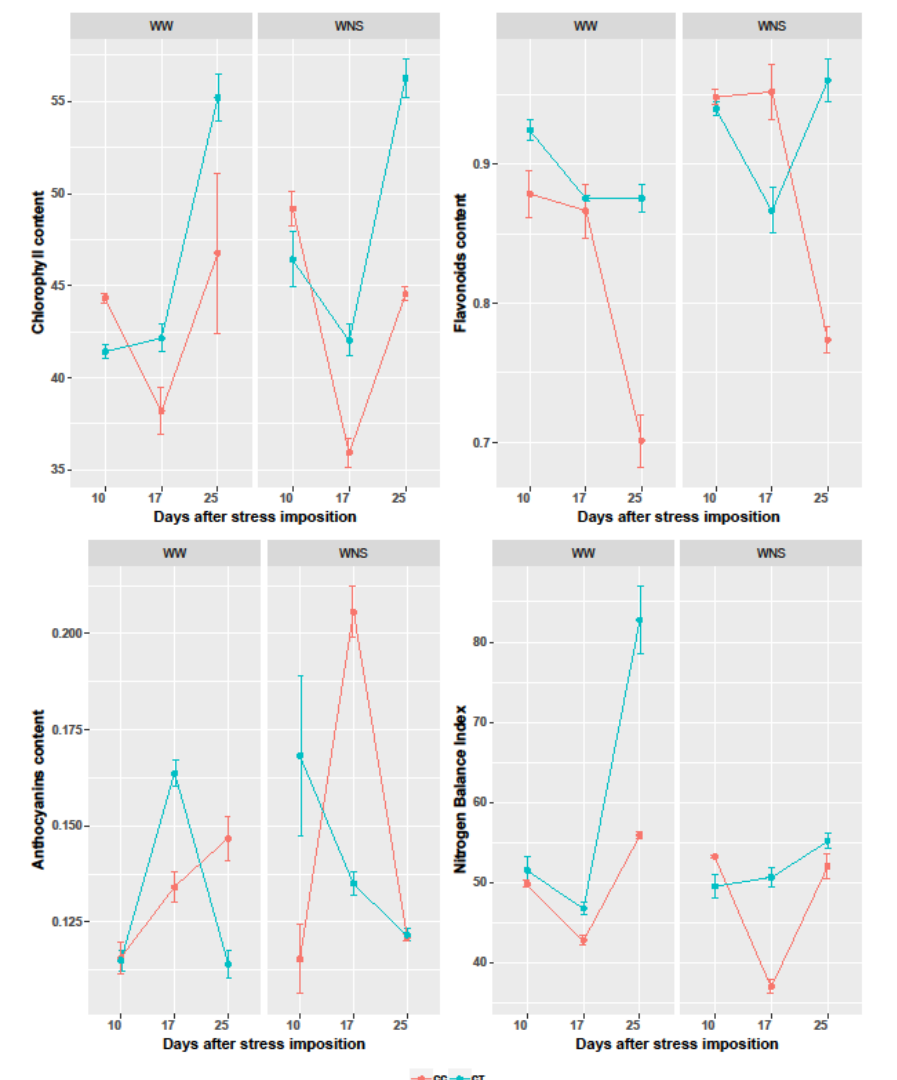
Figure 4. Chlorophyll, flavonoids, anthocyanins, and nitrogen balance index in leaves of wheat plants either well-watered or water/nutrient stressed, WW: Well-watered; WNS: Water/nutrient stress; CC: Coated control; CT: Coated with thyme